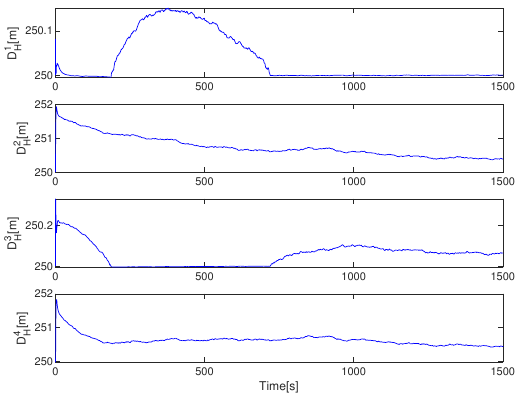
Figure 9. Horizontal distances of four towlines using proposed control method.